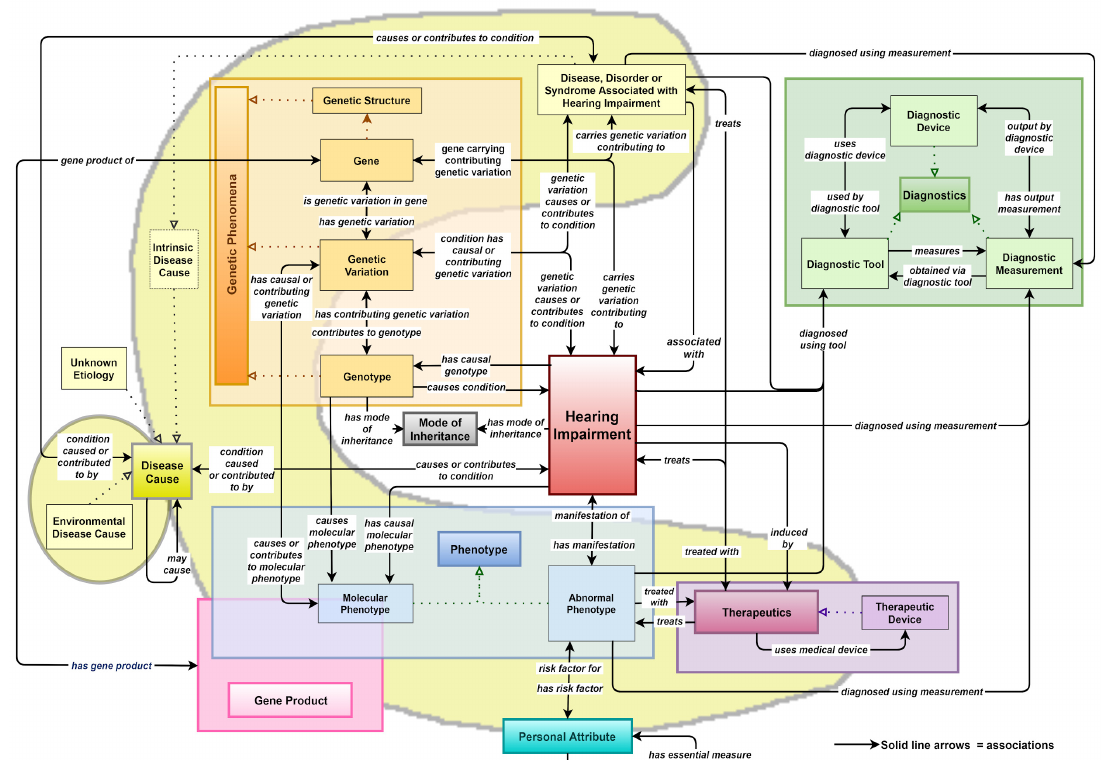
Figure 6. Associations made in the HIO between upper level (close to the root of the ontology) classes (excluding ‘Modifier’ class and only including ‘Disease Cause’ sub-class (yellow shapes) of the ‘Disease Attribute’ class). The ‘Hearing Impairment’ class is the central class.